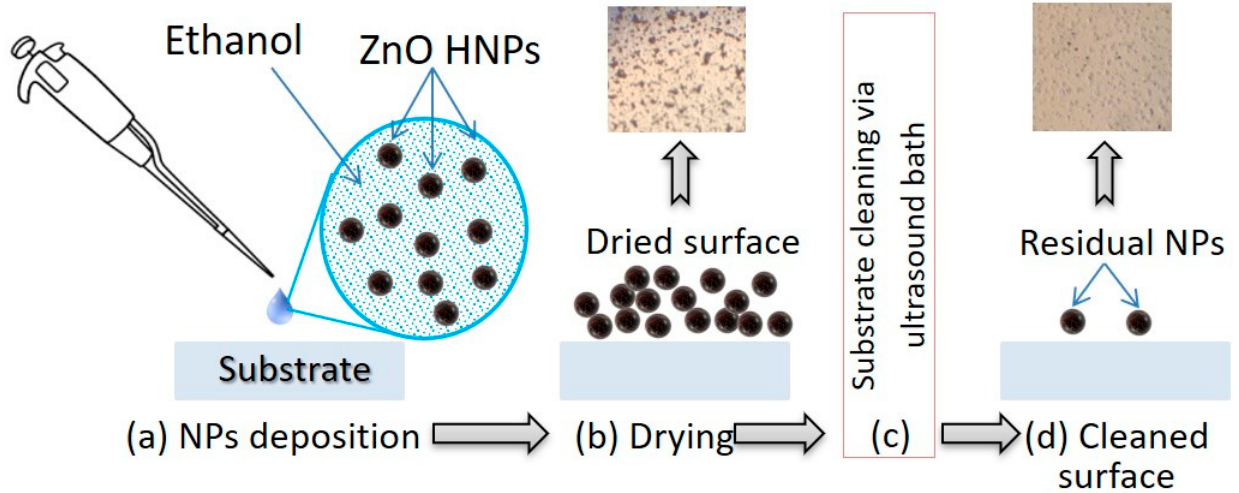
Figure 2. Main stages of the HNPs deposition and cleaning procedure: ( a ), ( b ) Deposition of HNPs by evaporation from colloidal suspension; ( c ) cleaning of the surface of the sample by 3 min treatment in ultrasonic bath; ( d ) drying of the “cleaned” area. Inserted photos show the dense layer of the ZnO NPs aggregates before and after cleaning in ultrasonic bath. Table 1. The real Re ( χ (3) ) and imaginary Im( χ (3) ) parts of the cubic NLO susceptibility at 1064 nm for the samples of P(VDF-TrFE) copolymer with different thickness L. Asterisk “*” marks the sam- ples without poling.